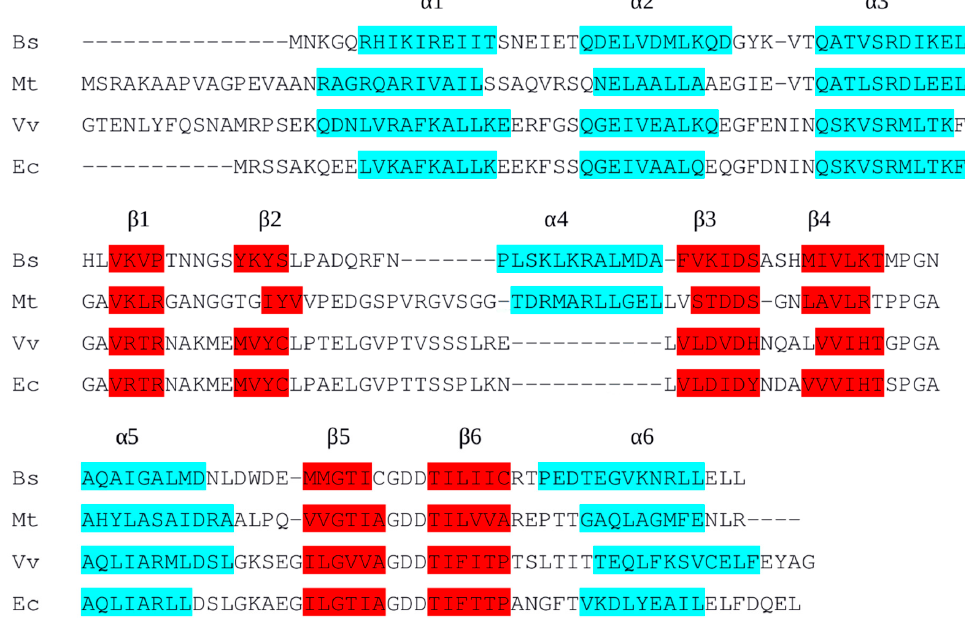
Figure 1. Structure-based sequence alignment. α -helices (cyan) and β -strands (red) are based on each respective PDB structure (BsArgR, PDB ID: 1F9N; MtArgR, PDB ID: 3FHZ; VvArgR, PDB ID: 3V4G; EcArgR: EcArgRN, PDB ID: 1AOY; EcArgRC, PDB ID: 1XXA). Although EcArgR and VvArgR